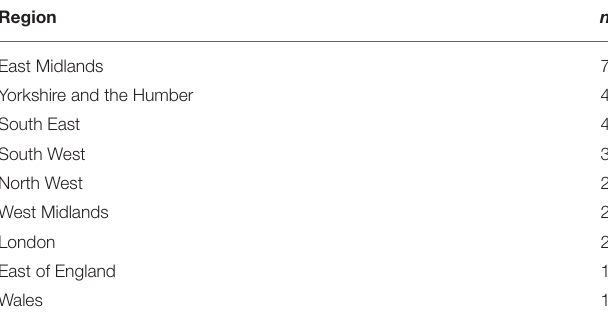
TABLE 1 | Club staff regional localities.